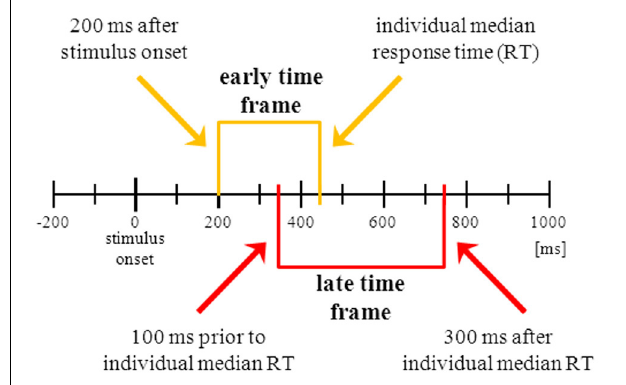
FIGURE 2 | Visualization of the two predefined time windows in which the independent component’s (IC) latency range of significant activation had to be confined. Starting point of the “early” time frame (yellow brackets) is 200ms after stimulus onset, ending point is the individual median correct Go response time (RT). The “late” time frame (red brackets) starts 100ms prior to RT and ends 300ms after RT. To be selected, the IC’s latency range of reliable activation must be wholly contained within one of the predefined time windows, i.e., the Nogo minus Go absolute Z- score must arise above threshold (| Z | > 0.275) and must fall below threshold (| Z | < 0.275) within the time window. Black bars depicting 100ms